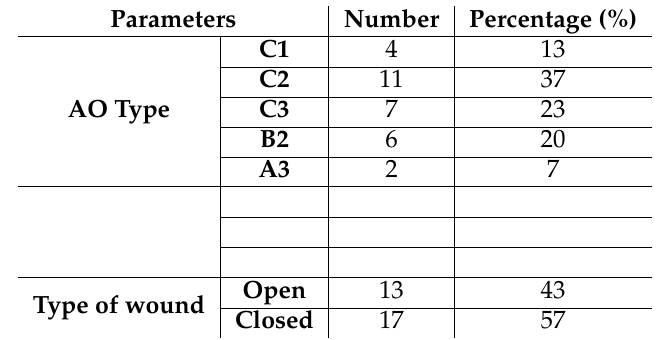
Table 1. Distribution of study subjects according to AO classification, Ruedi-Allgower classification, and wound